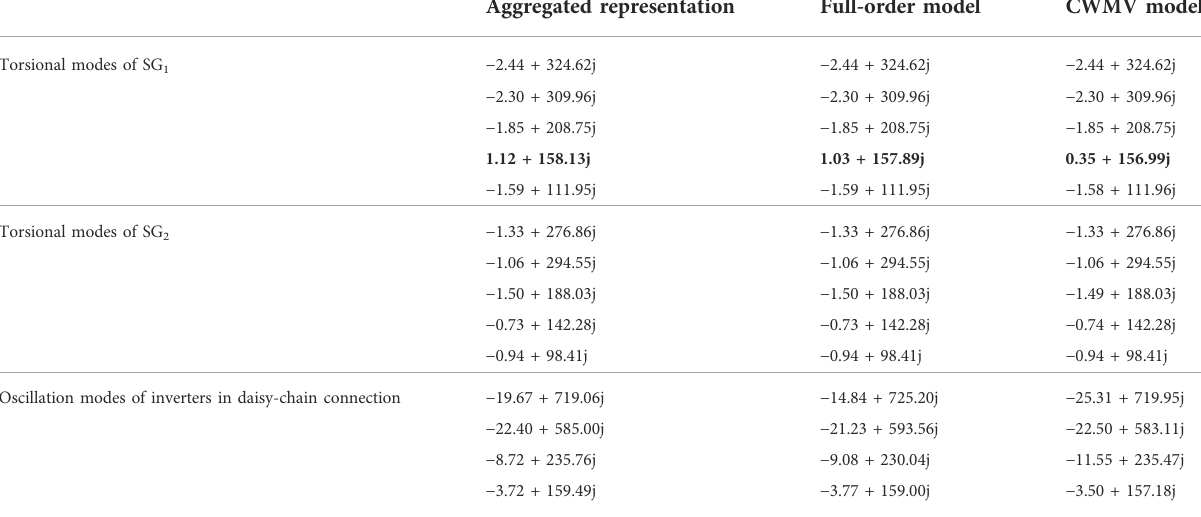
TABLE 6 External oscillation modes of the example power system (case study 4).